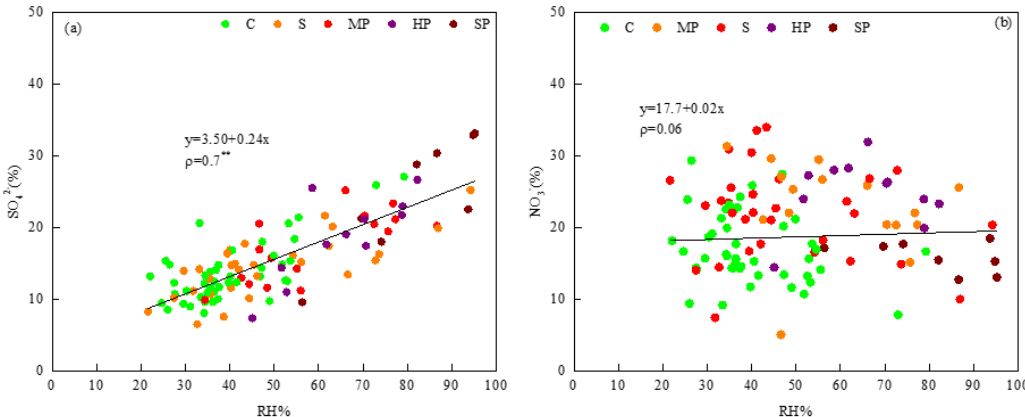
Figure 7. Relationships between relative humidity(RH) and the proportions of SO 42 − ( a ) and NO 3 − ( b ) in PM 2.5. (note: ** indicates ρ < 0.01).